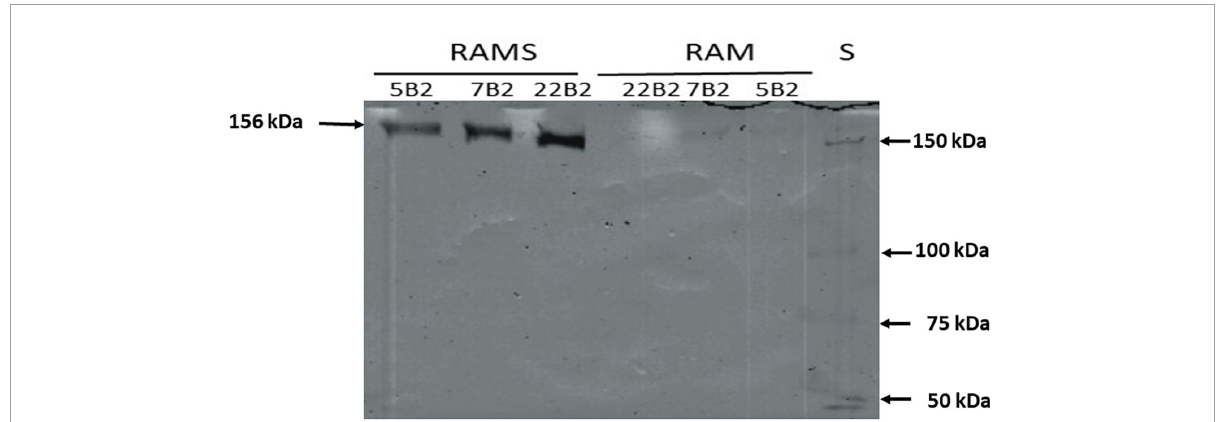
FIGURE4 In situ detection of dextransucrase activity in cell free supernatants of LAB cultures. The indicated Weissella cibaria riboflavin-overproducing strains were grown in the presence of glucose [Riboflavin assay medium (RAM)] or glucose plus sucrose [Riboflavin assay medium with sucrose (RAMS)], the culture supernatants were subjected to SDS-PAGE and after protein renaturation, were analyzed in situ for Dsr activity. S, protein Mw standard.